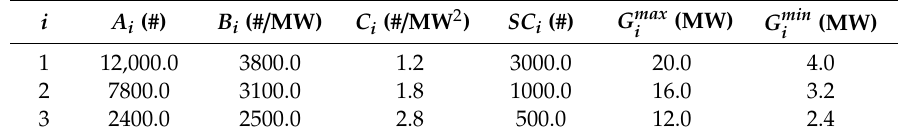
Figure 2. ( a ) Forecasted net load; ( b ) electricity price. Table 1. Specification of CGs (“#” means “any currency unit is applicable”).